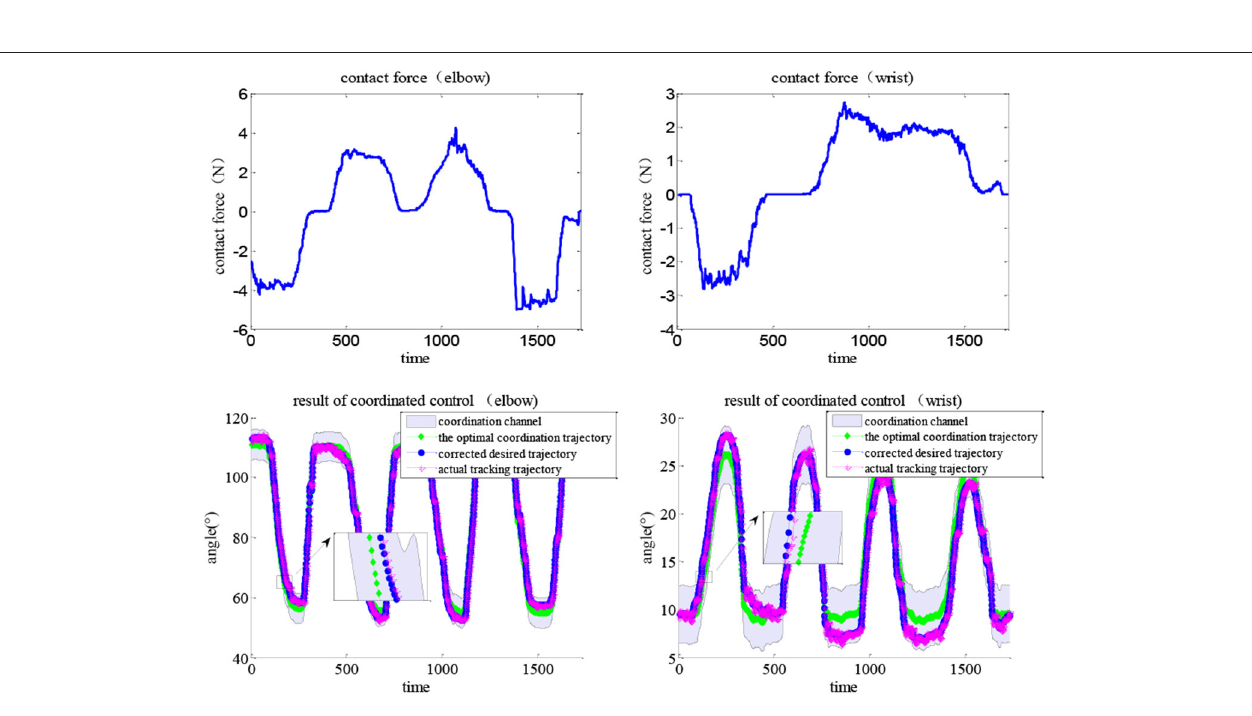
Frontiers in Neurorobotics |